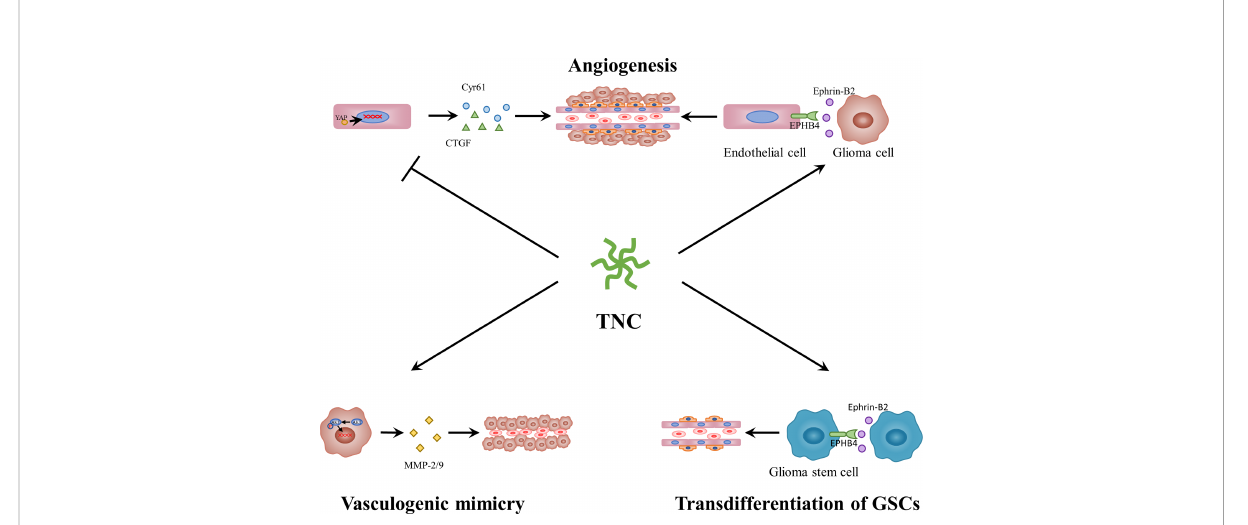
FIGURE 3 The roles of TNC in glioma neovascularization. On the one hand, TNC blocks YAP signaling and endothelial cell behavior through direct contact. On the other hand, TNC induces ephrin-B2 and a pro-angiogenic secretome in glioblastoma cells. In addition, TNC activates AKT/ MMP2/MMP9 axis and further promotes vasculogenic mimicry in glioma. Moreover, TNC-ephrinB2-ephB4 signaling pathway supports GSCs differentiation into endothelial cells. YAP, Yes-associated protein; MMP, matrix